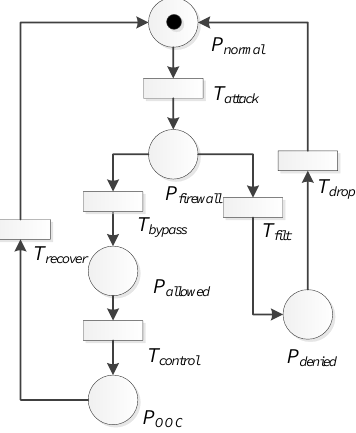
Figure 7. Defense Scenario I: the SPN